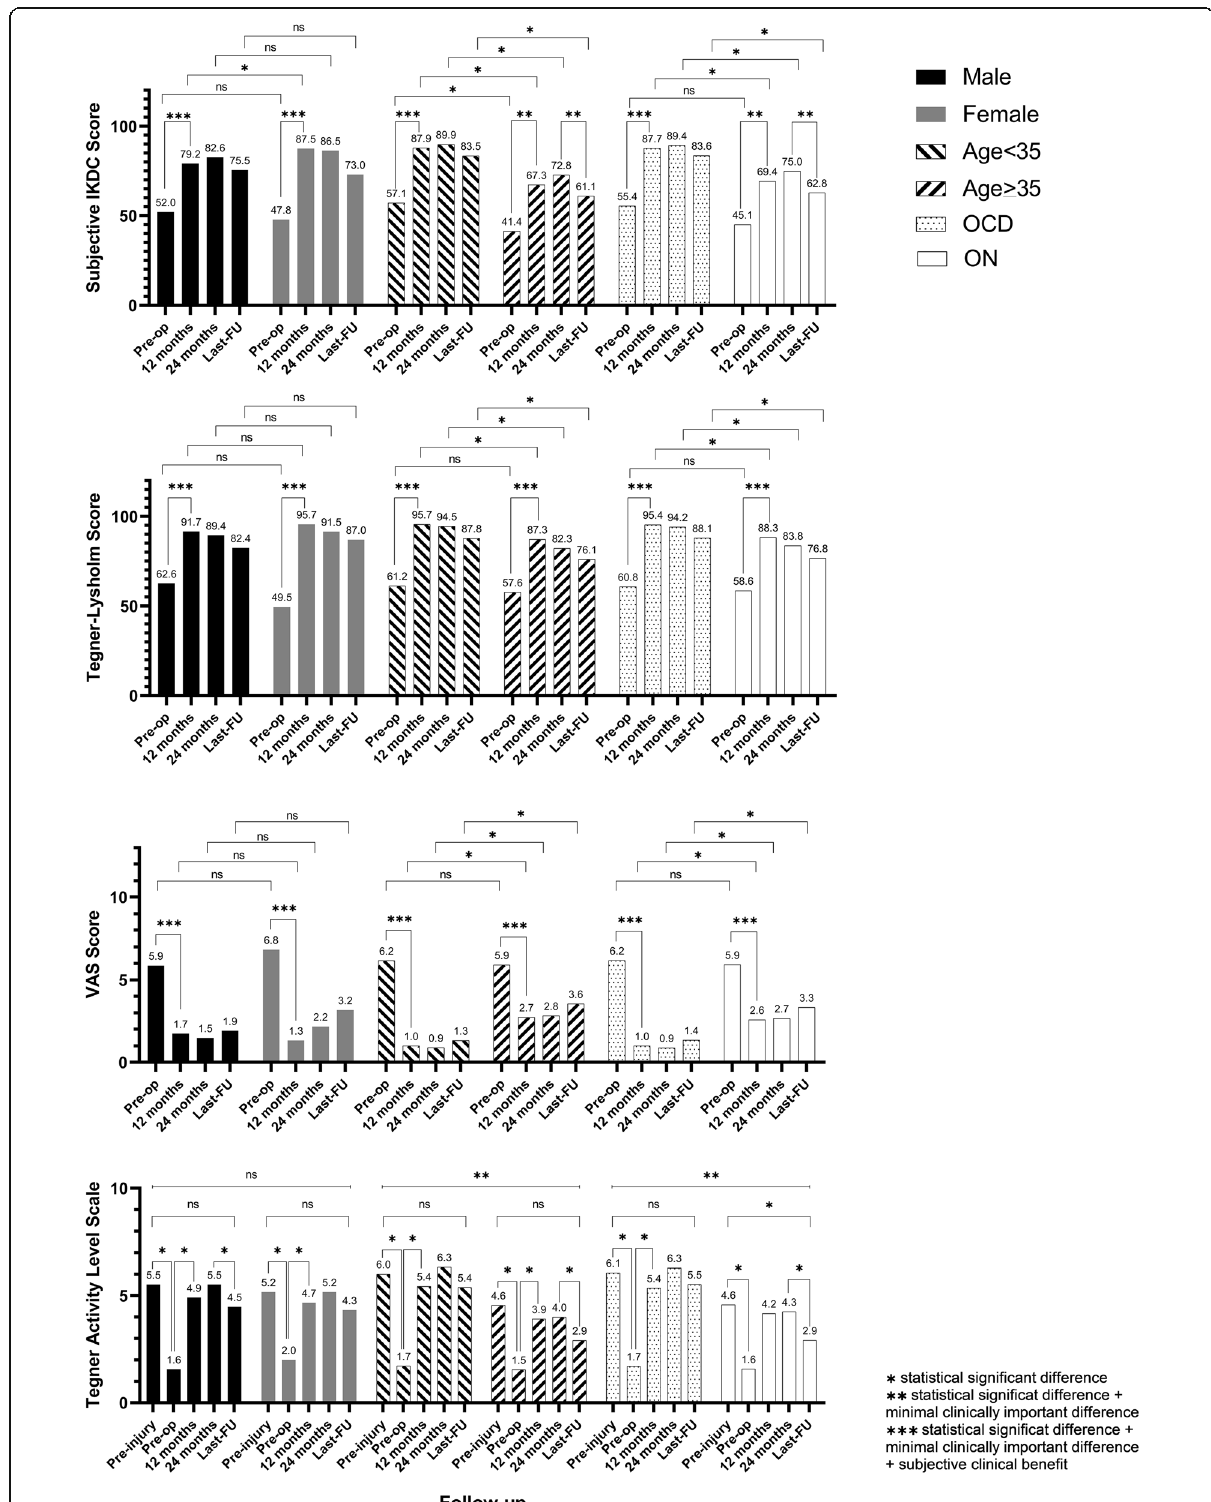
Fig. 3 Subgroups analysis. Analysis of data depending on gender (Male/Female), age (< 35/> 35 years) and lesion etiology (Osteochondritis Dissecans/Osteonecrosis) for Subjective IKDC Score, Tegner-Lysholm score, VAS and Tegner Activity Level Scale (NS = not statistically